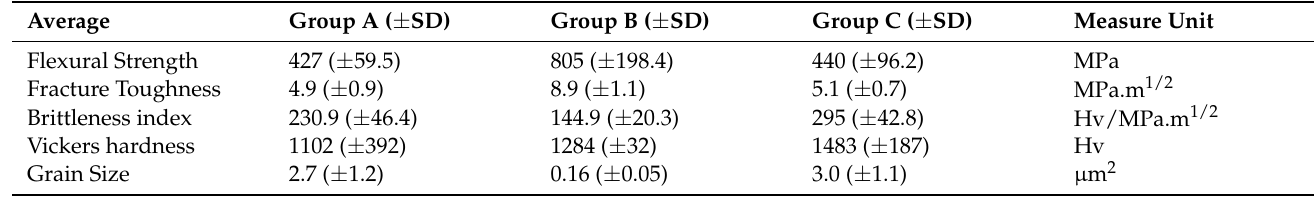
Table 2. Summary of the